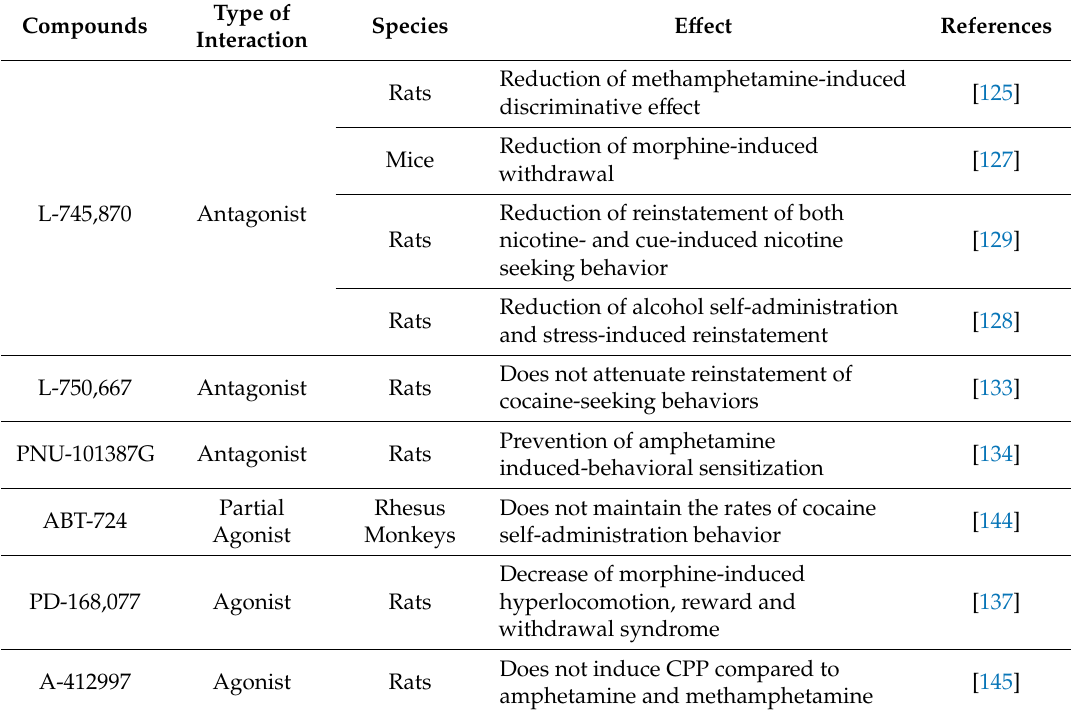
Table 1. Dopamine D4 receptor (DRD4) compounds in drug